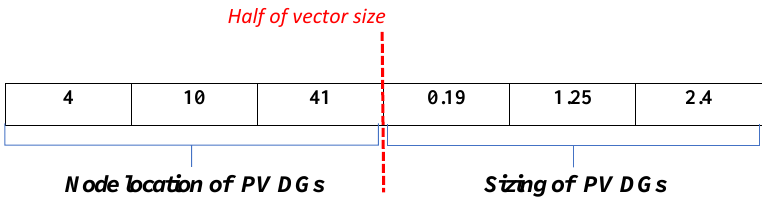
Figure 1. Codification used for the optimal integration of PV